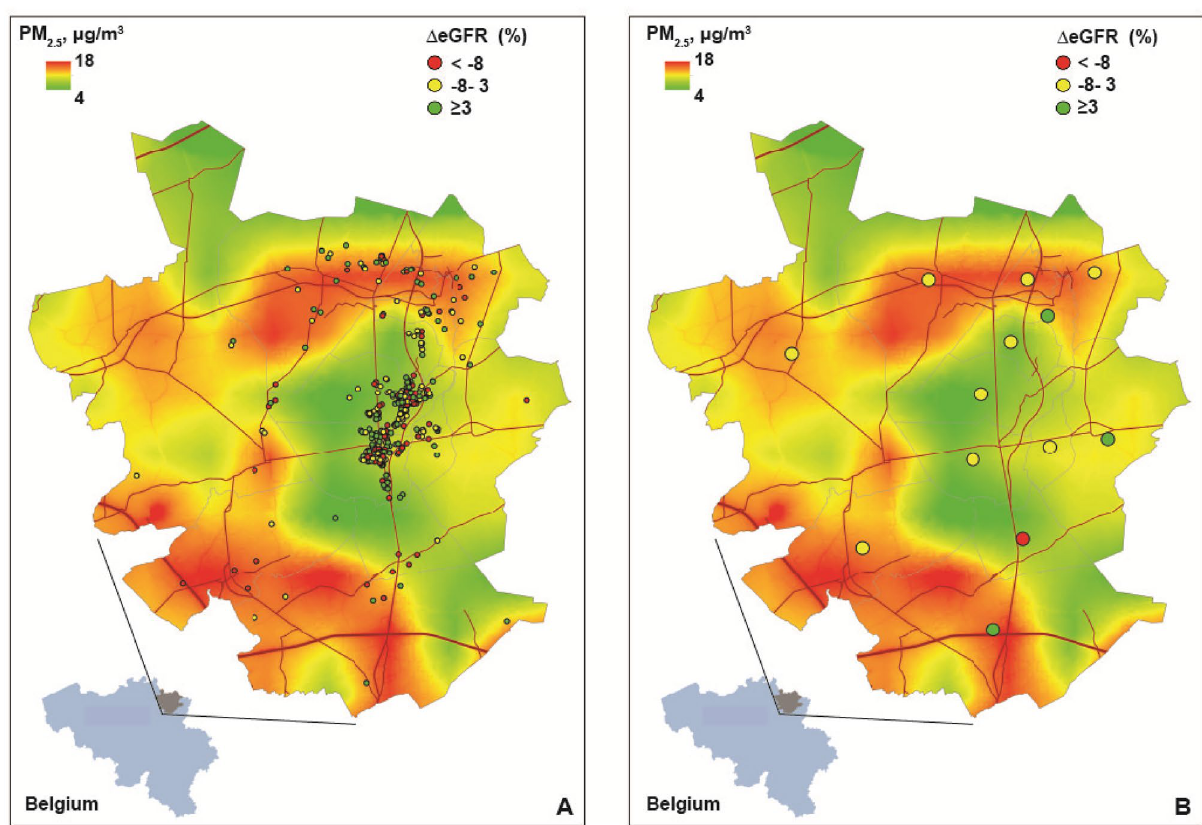
Figure 2. Geographical associations of the multivariable-adjusted percent change in the glomerular filtration rate estimated from serum creatinine (ΔeGFR) at the individual level ( A ) or aggregated per municipality ( B ) with PM 2.5 air pollution contours. Grey lines indicate borders of municipalities. Red lines represent the air pollution contours of major roads. The Spearman rank correlation coefficients between percent change in eGFR and the exposure to PM 2.5 were − 0.016 ( P = 0.69) and − 0.022 ( P = 0.94) in the individual and aggregated data,